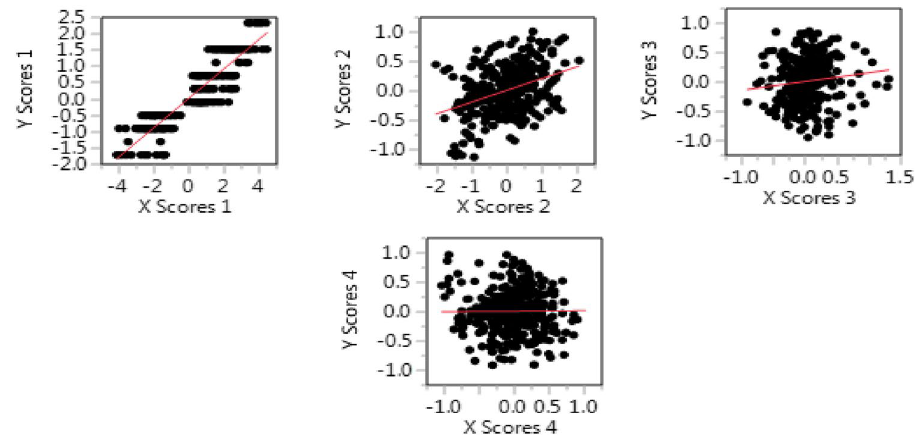
Fig. 16 Scores plots for ECD model